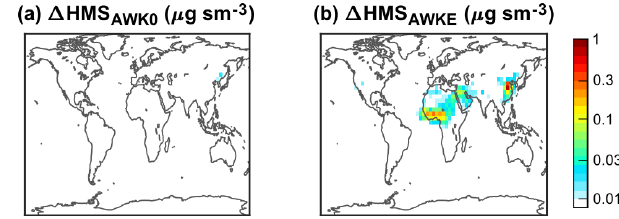
Figure 7. Difference in surface HMS concentrations in DJF (December–January–February) between two sensitivity simulations (AWK0 a and AWKE b ) and the default simulation (DFLT). The color bar is not